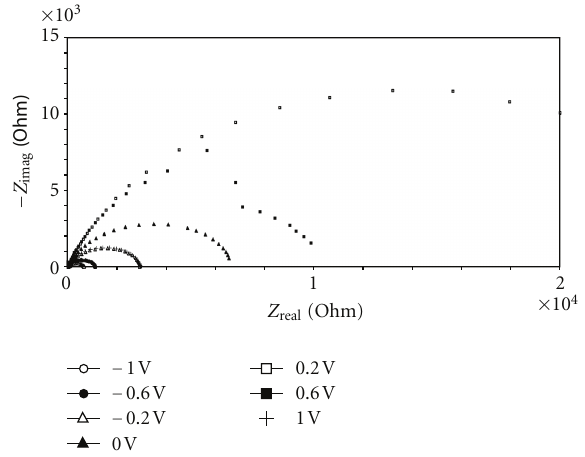
Figure 7: Nyquist impedance spectra of Al/n-Si/PANI-DBSA/Au heterojunctions under illumination (0.09 W/cm 2 ) at di ff erent potentials.